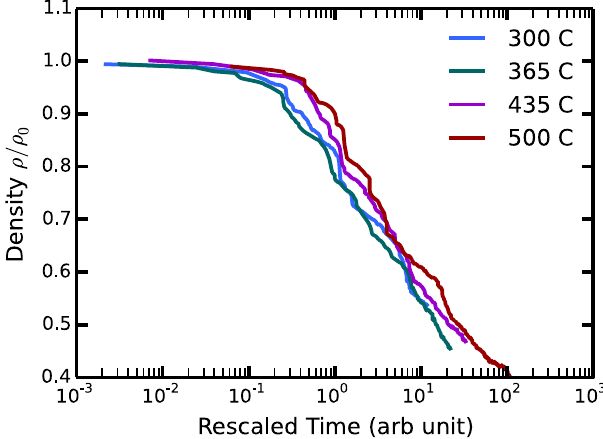
Fig. 5 The effect of temperature on the recovery process. When time is re-scaled by diffusivity, the recovery trend collapses to a single curve which is primarily – though not entirely – temperature